Question: What does this figure show? Answer in one sentence.
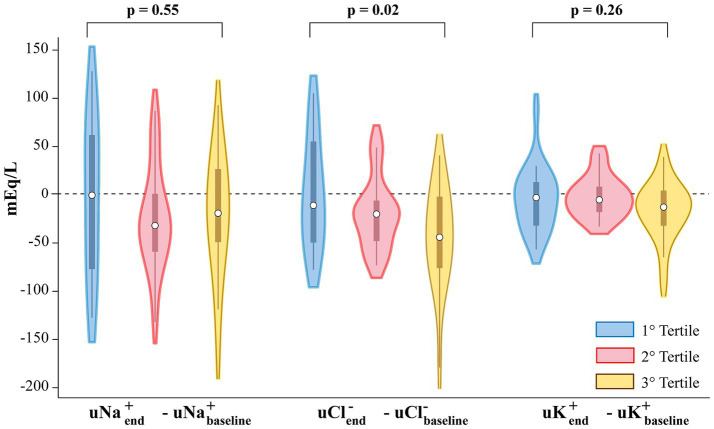
Answer: Difference between the end of the study and baseline urinary electrolytes, stratified by tertiles of the mean SID INF –HCO₃ − difference. Blue plots represent the first tertile, red plots the second tertile, and yellow plots the third tertile. Variations are calculated as the difference between end-of-study and baseline values for each parameter. Data are presented as violin plot (median reported by the white dot, 25th-75th percentile, whiskers indicate the 10th–90th percentiles). p values refer to one-way analysis of variance (ANOVA) performed for each electrolyte.